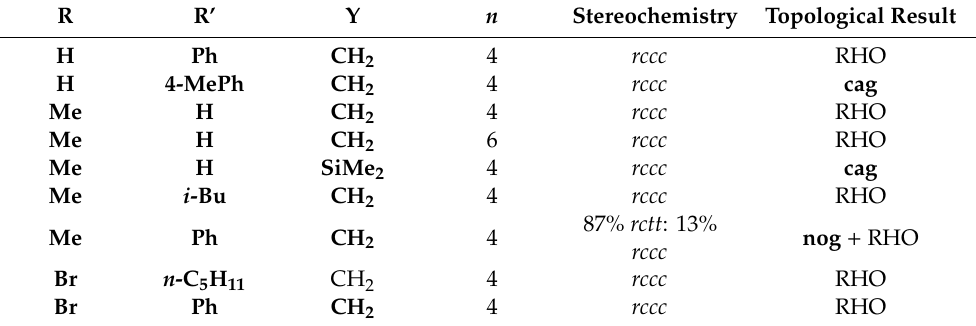
Table 1. Summary of cavitand putative templates explored in the LAG-aging reactions between zinc oxide, imidazole, DEF, and RR’Y - n cavitand (Figure 1), as well as the framework topological products of the